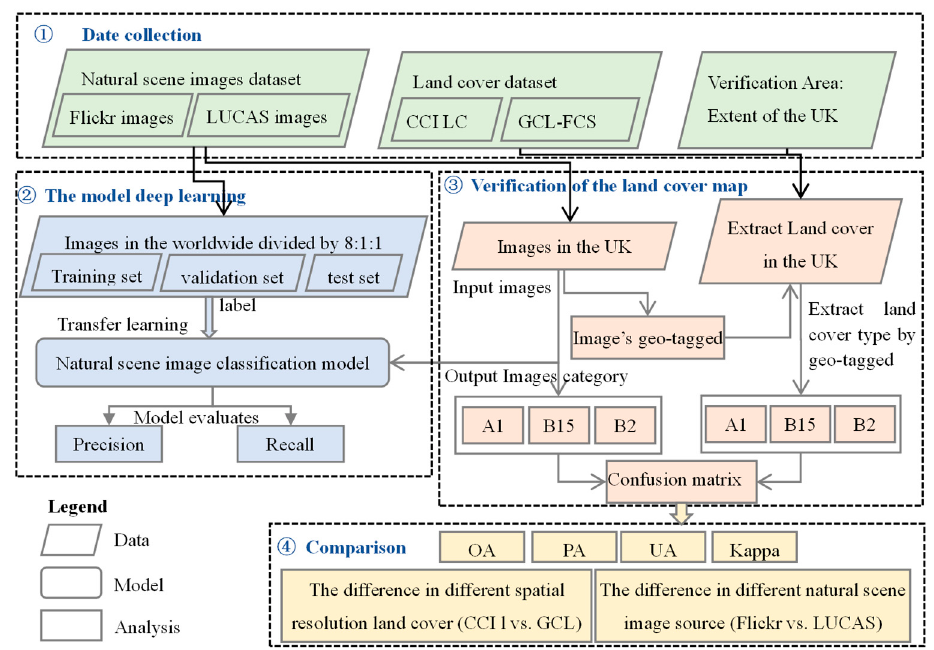
Figure 1. The workflow of the proposed method.